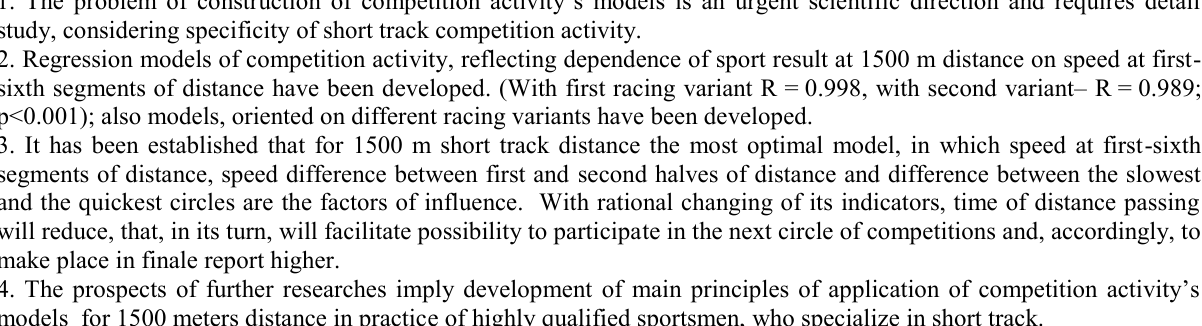
Models of competition activity at 1500 m distance, oriented on different racing variants. First variant Second variant Mean speed at first segment is by 27.0 – 32.1 % lower than average-distance one. Speed is increasing gradually up to the end of distance. At second segment speed is lower by 1.8 – 5.9 %, than average-distance. At third segment speed is higher than mean-distance one by 3.2 – 5.4 % at the forth segment – by 7.7 – 10.2 %. At fifth segment the highest speed - by 11.6 – 15.4 %. Time of one slow circle is 11.5 – 13.0 sec. Time of the quickest circle – is – 8.9 – 9.2 sec. Mean speed at first half of distance is– 10.32 m.p.sec -1 , at the second– 11.94 m.p.sec -1 , that corresponds to circle time 9.3 and 10.8 sec. correspondingly. Difference between speed at first and second halves of distance shall not exceed 1,6 m.p.sec -1 . Overtaking number – 3 – 4, improved by overtaking positions– 2 – 3, quantity of circles at qualification position– 5 – 6, at leading position– 2 – 3. Result depends on speed at all segments of distance, on difference between mean speed at first and second halves of distance, on time of the slowest circle, on difference between the slowest and quickest